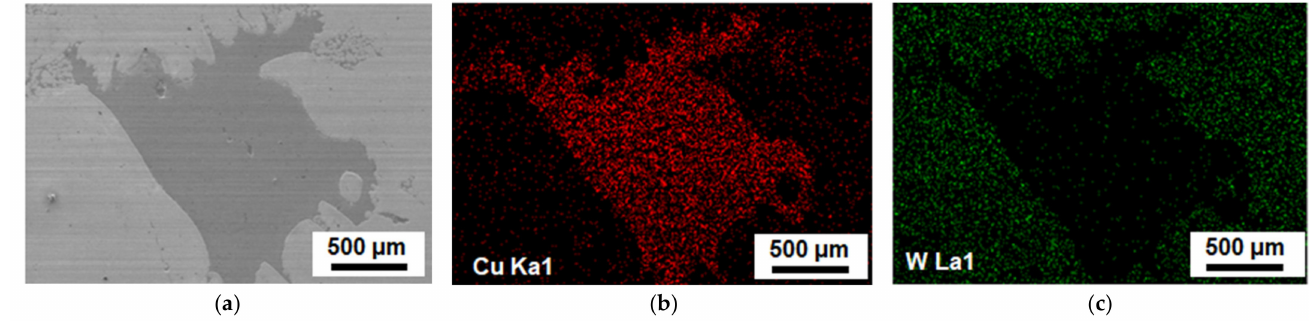
Figure 3. SEM micrographs ( a ) and EDS analysis ( b , c ) of the Cu-W composite with a cubic-W-skeleton.